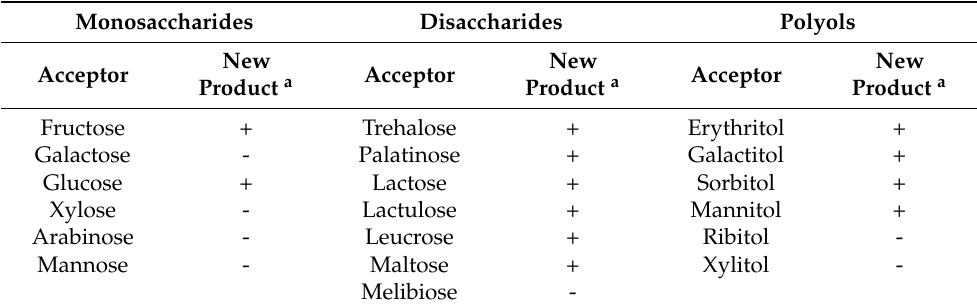
Table 3. Fructosyl-acceptor specificity of the RdINV expressed in P. pastoris.